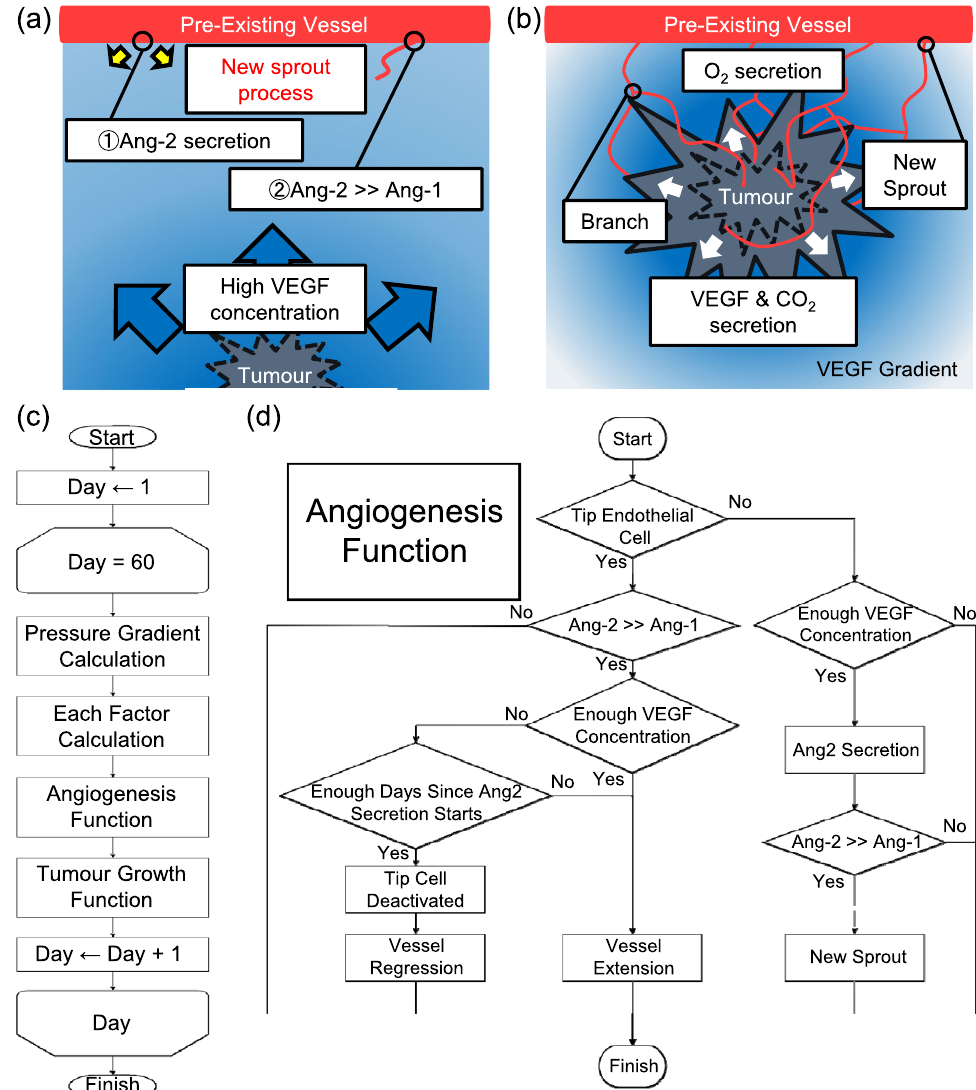
Figure 1. Model concept and flowchart. ( a ) and ( b ) Formation of a new vascular network via angiogenesis: Existing vascular endothelial cells secrete Ang2 in response to tumour-secreted VEGF stimulation. When [Ang2] levels become sufficiently higher than [Ang1] levels, the vessel releases wall cells and new vessels sprout. Sprouting vessels extend according to the [VEGF] gradient. Neovascularization forms a dense vascular network around the tumour. Tumours proliferate utilizing a well-developed vascular network which allows them to acquire nutrients and expel metabolites; ( c ) An overall flowchart of the simulation. The pipeline, including pressure gradient, each factor, angiogenesis, and tumour growth, was repeated for 60 days; ( d ) Details of angiogenesis function. VEGF stimulation caused Ang2 secretion in blood vessels, resulting in [Ang2] >> [Ang1] and the extension of new blood vessels. Tip endothelial cells in [Ang2] > > [Ang1] are deactivated and regressed, with probability, p rg , calculated from